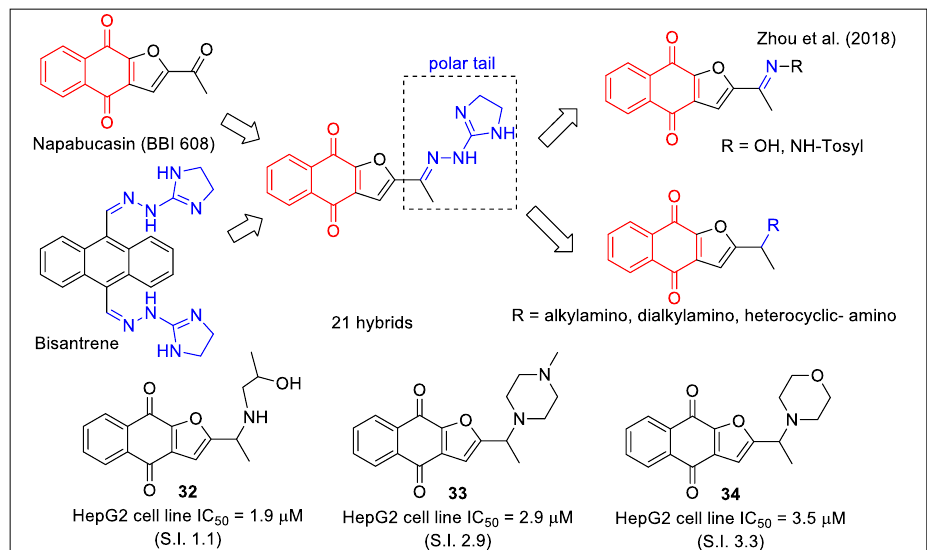
Figure 13. 1,4-Naphthoquinone hybrids with imino- and amino-urane scaffold as reported by Zhou et al. [46].